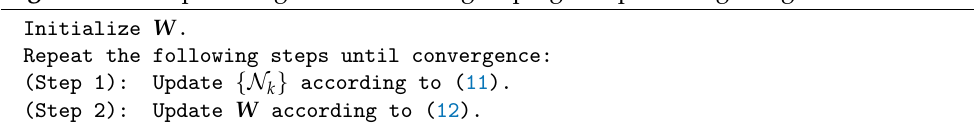
Algorithm 1 Proposed algorithm for user grouping and precoding